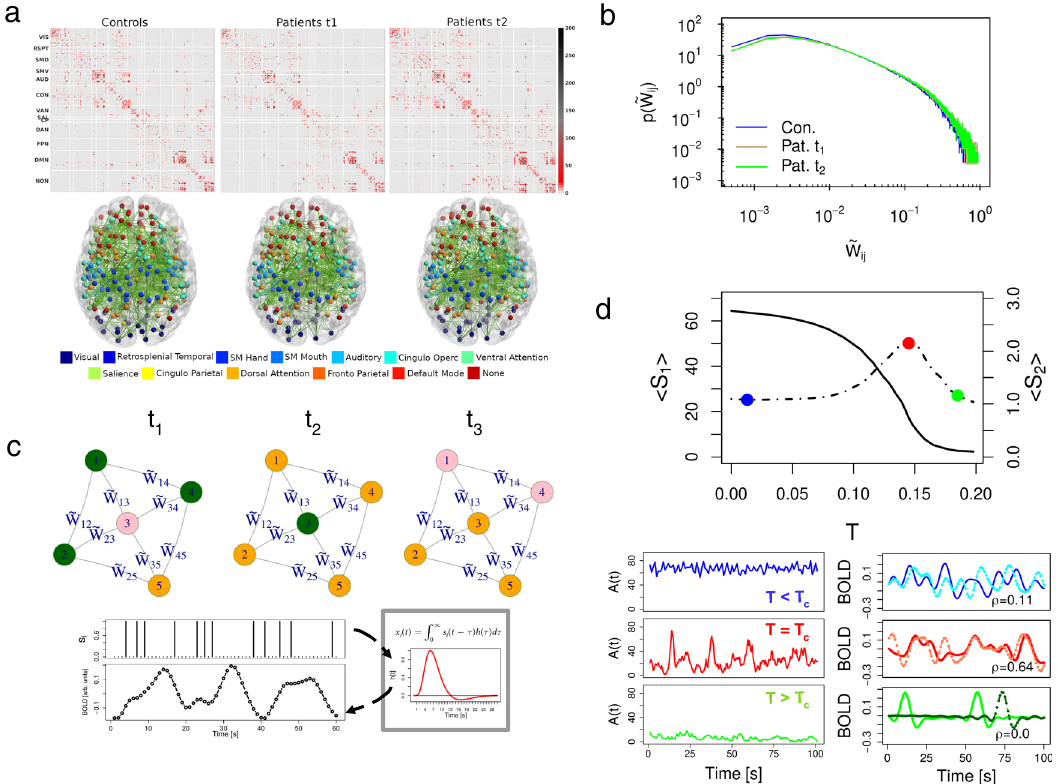
Fig. 1 Overview of whole-brain modeling. a Average structural connectivity (SC) matrices (top) and their corresponding network architecture embedded in a glass dorsal view of the brain (bottom). SC matrices and brain networks are organized according to regions of interest (ROI) de fi ned on the cortical parcellation of Gordon et al. 59 . b The probability distribution function of the structural connectivity weights in controls and patients after homeostatic normalization (see main text, Eq. (1)). For each group, the (non-zero) weights of all individual matrices were pooled together and then the histogram was computed leading to a representative pdf for the corresponding group. c Top. Illustration of the network dynamics with homeostatic plasticity following the transition probabilities between the three possible states: inactive ( I ), active ( A ) and refractory ( R ). The temporal evolution of the central inactive node (pink) is as follows: in t 1 , it is surrounded by three active nodes (green) and one refractory node (orange); in t 2 , the incoming excitation is propagated ( e W 31 þ e W 32 þ e W 34 > T ); and fi nally, in t 3 , it reaches the refractory state. Bottom. Procedure used to transform node's activity, s i ( t ), in functional BOLD signals, x i ( t ). BOLD time-series are obtained by convolving instantaneous s i ( t ) with a canonical hemodynamic response function (HRF). d Behavior of the neural variables, the largest ( S 1 , continuous line), and the second largest ( S 2 , dotted line) cluster size as a function of T (top). The peak in S 2 (red dot) is identi fi ed as the critical phase transition 62 . Blue and green dots correspond to minimal and maximal values of T , and corresponding activity and BOLD time- series in the lower panels. Left panel: instantaneous network activity, A ( t ) = ∑ i s i ( t ), for different values of the activation threshold T ; the super-critical phase T ≪ T c (blue time-series), the critical phase T = T c (red) and the sub-critical phase T ≫ T c (green). Right panel: example of the simulated BOLD signals between two arbitrary ROIs and their corresponding Pearson correlation ρ . The highest correlation is achieved at the critical phase, where BOLD fl uctuations are network are visible (dorsal view of the brain Fig. 1a). In stroke patients, inter-hemispheric connectivity is decreased, as shown by Grif fi s et al. 35 who found that loss of inter-hemispheric connections — both structural and functional — is the predominant aberrant pattern in stroke. The lesion load topography in the stroke cohort is shown in Supplementary Fig. 1 and matches the topography of larger cohorts 51,60 .